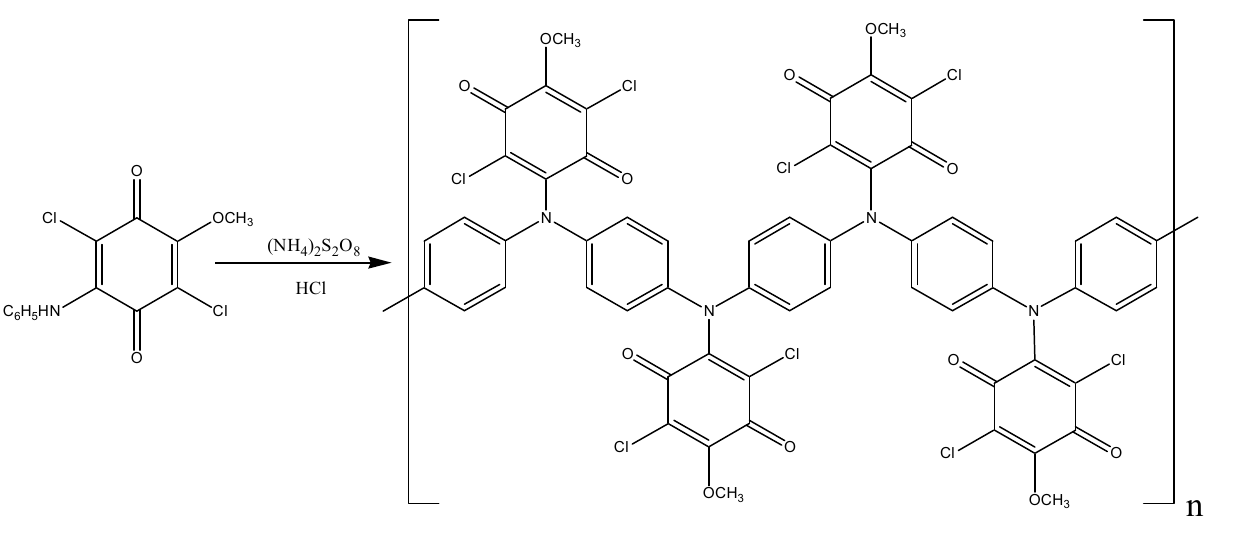
Scheme 4. Poly-MADCB synthesis scheme.